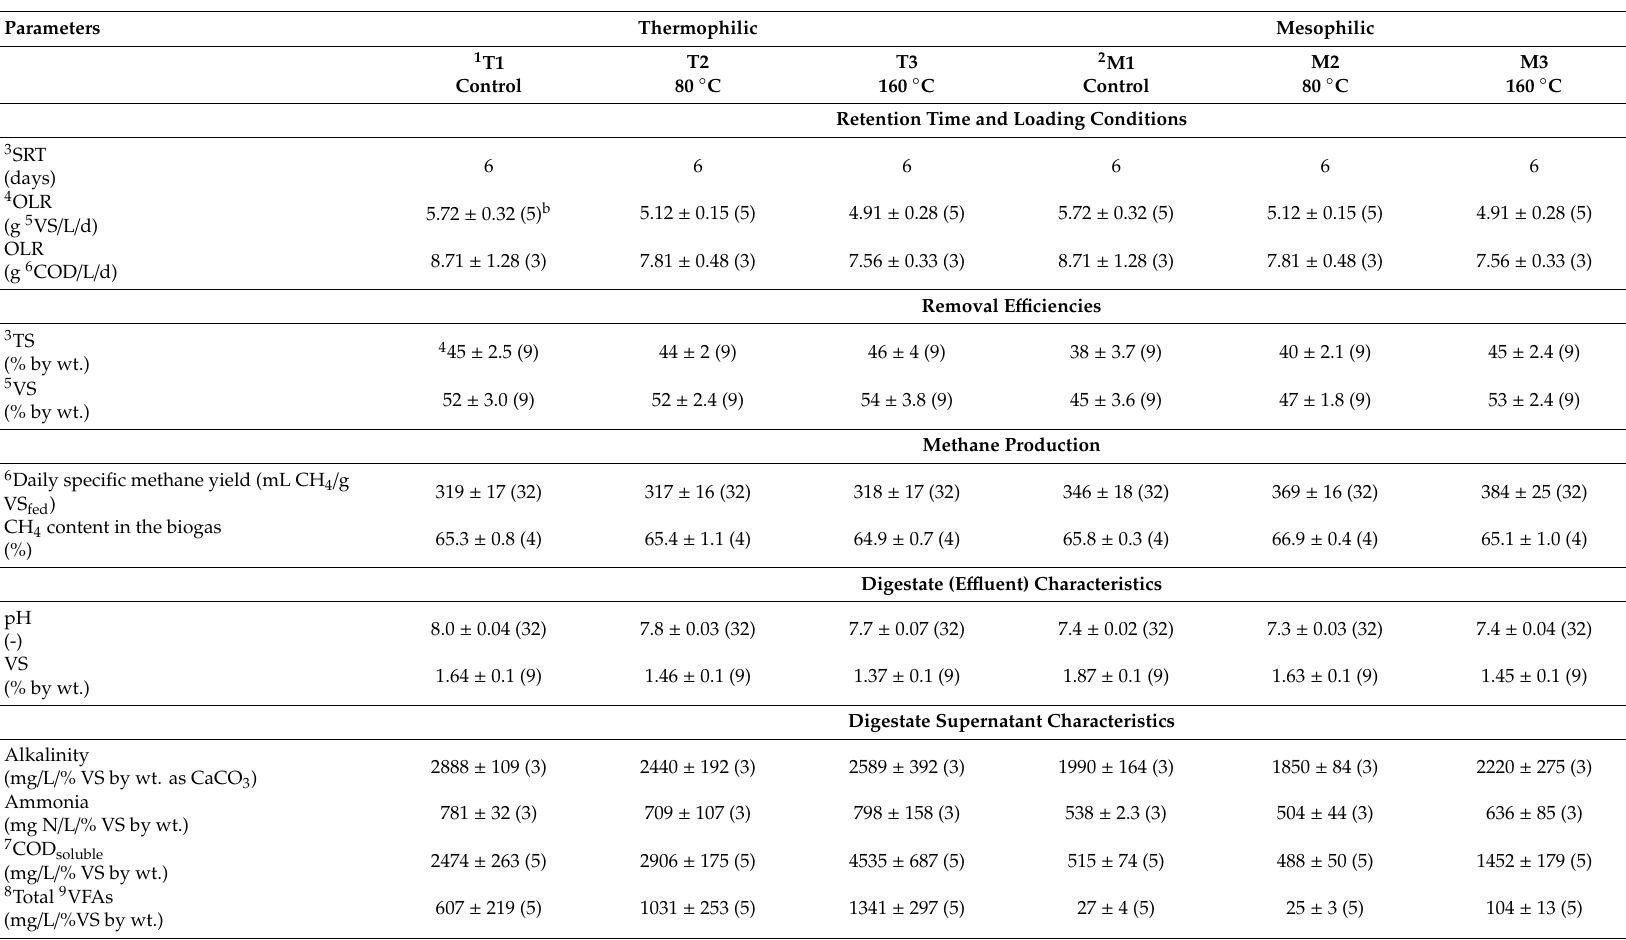
Table 5. Operating conditions and steady-state performances of bench-scale anaerobic digesters fed with non-irradiated (control) and MW-irradiated mixed sludge.